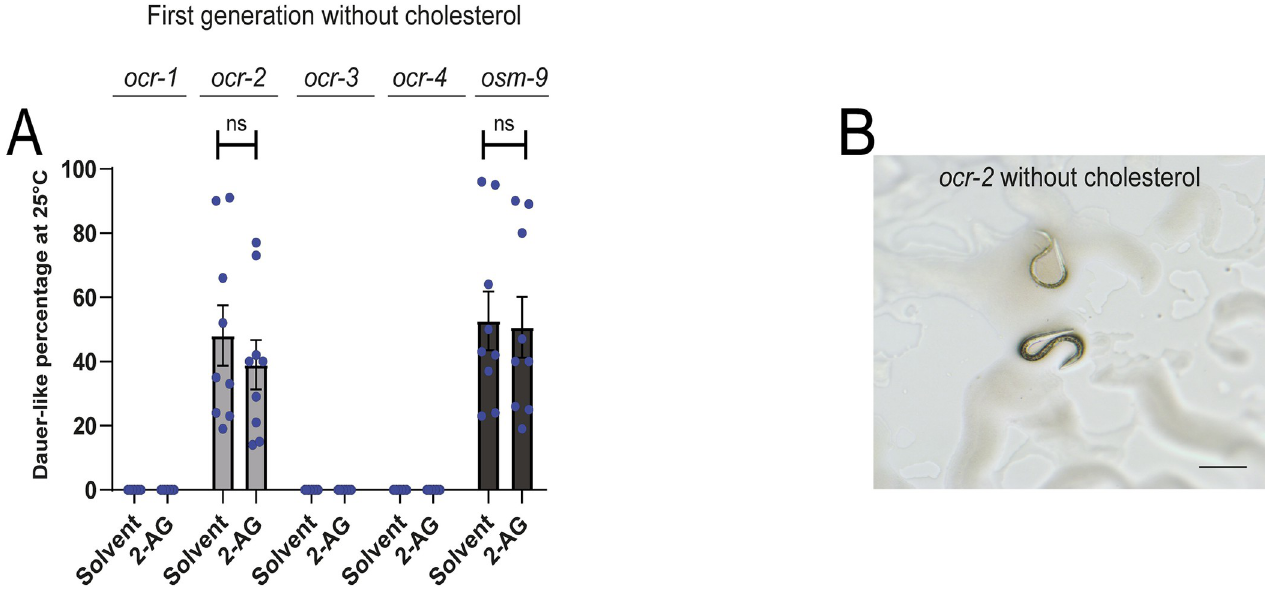
Fig 3. ocr-2 and osm-9 are required for 2-AG-dependent cholesterol mobilization. (A) Worms were grown in media with 0 μ g/ml of cholesterol during one generation at 25˚C. All values are from n = 3 independent experiments shown as Mean ± SEM. ns = not significant. (B) ocr-2 undergoes dauer-like formation in the first generation when grown at 25˚C in cholesterol-free medium. The black straight line represents 0.25mm.